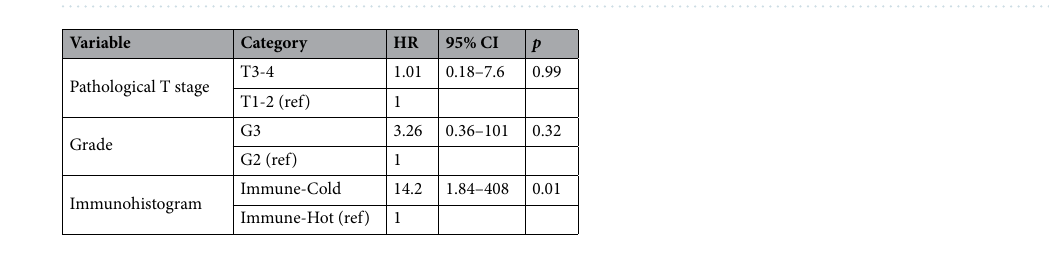
Table 4. Cox proportional hazard model for cancer specific survival after ICI therapy. HR, hazard ratio; CI, confidence interval.